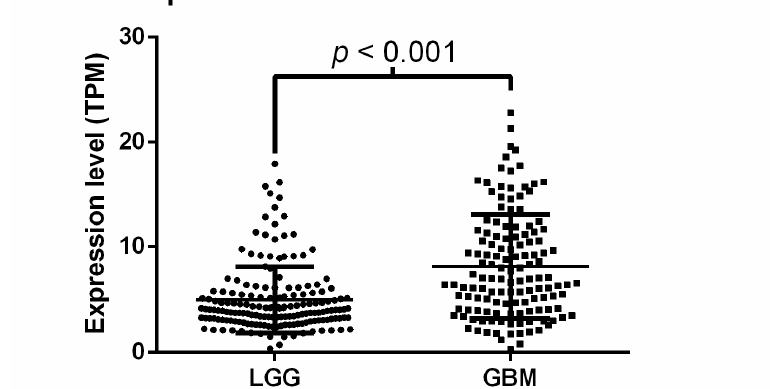
Figure 1. Comparison of ADAM9 mRNA expression levels between LGG and GBM tumor samples. The LGG tumor samples displayed an average of 4.098 ± 2.132 TPM units of ADAM9 mRNA expression, while GBM tumor samples displayed an average of 8.139 ± 4.922 TPM units of ADAM9 mRNA expression. The difference was significant between the two subtypes, p < 0.001, t -test. TPM, transcripts per million; LGG, lower-grade glioma; GBM, glioblastoma.